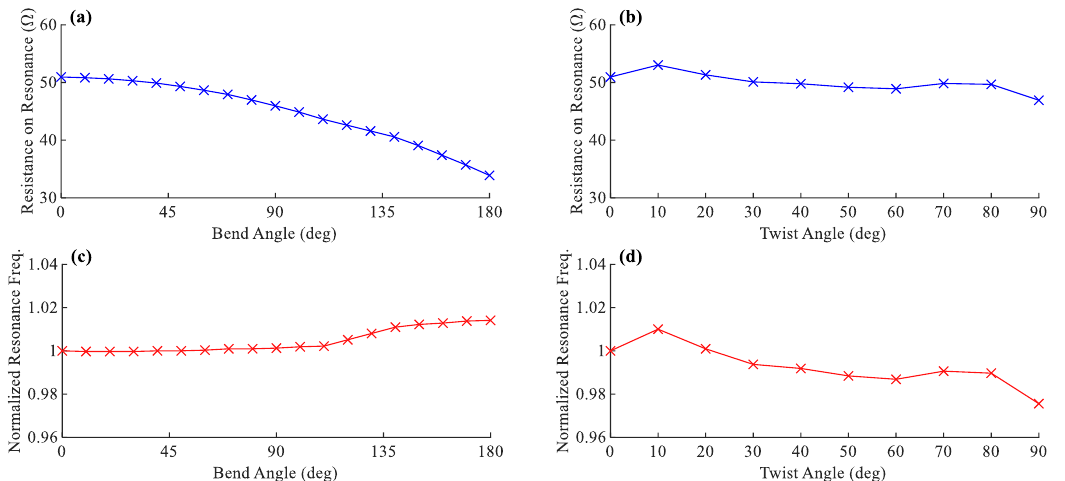
Figure 15. ( a , b ) The shift in antenna’s resistance on resonance and ( c , d ) its normalized resonance frequency for different angles of bending and twisting, respectively.